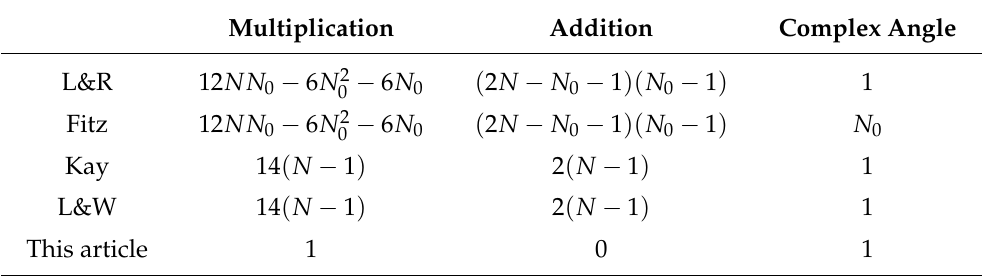
Table 2. Comparison of the complexity of frequency offset estimation